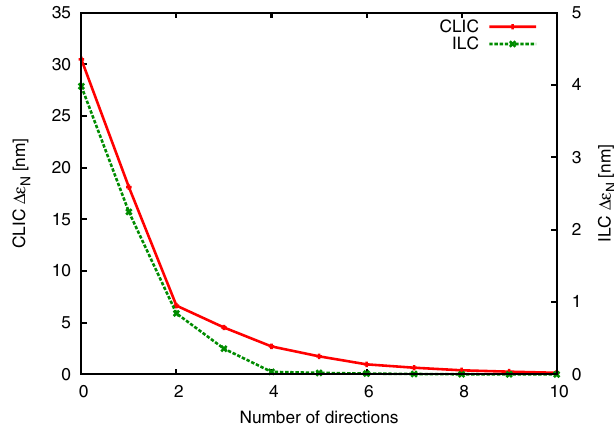
FIG. 10. Second-order approximation of the remaining emit- tance growth after optimization along the n most important principal seed directions. Observe that the emittance scales for CLIC and ILC differ. Optimization along ten directions is for CLIC enough to reduce emittance growth to 0.16 nm. For ILC four directions are sufficient to reduce emittance growth to less than 0.04 nm.